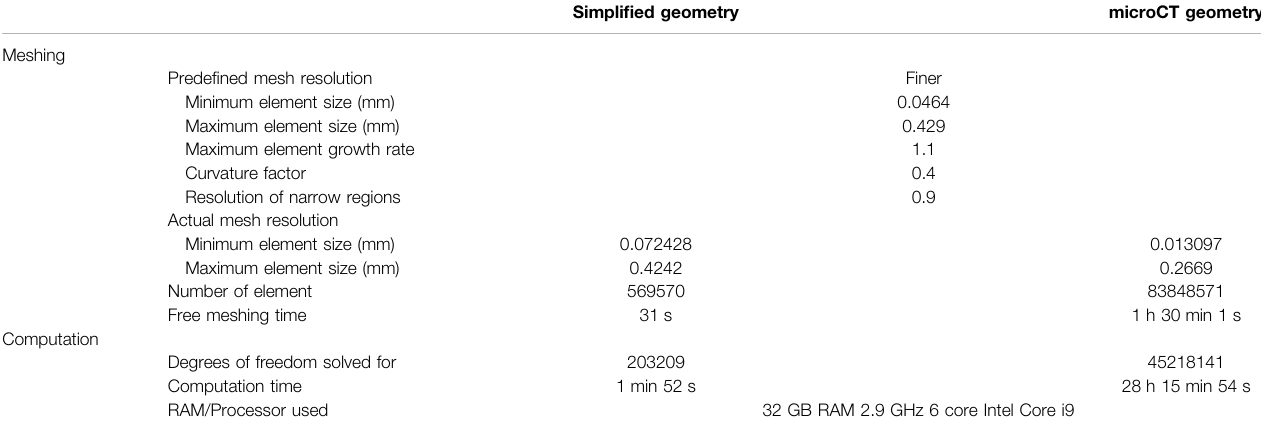
TABLE 1 | Parameters for meshing and computation in the in silico modeling.